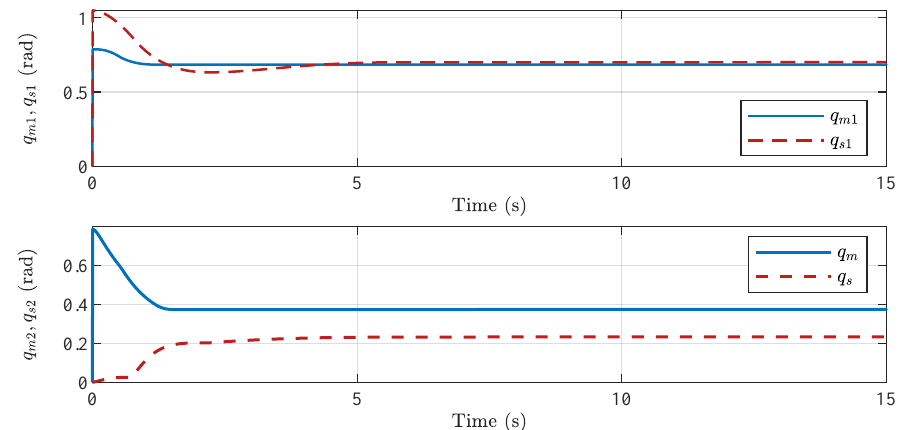
Figure 15. Comparisons of Joint tracking errors based on the proposed method and the method in Case 2.